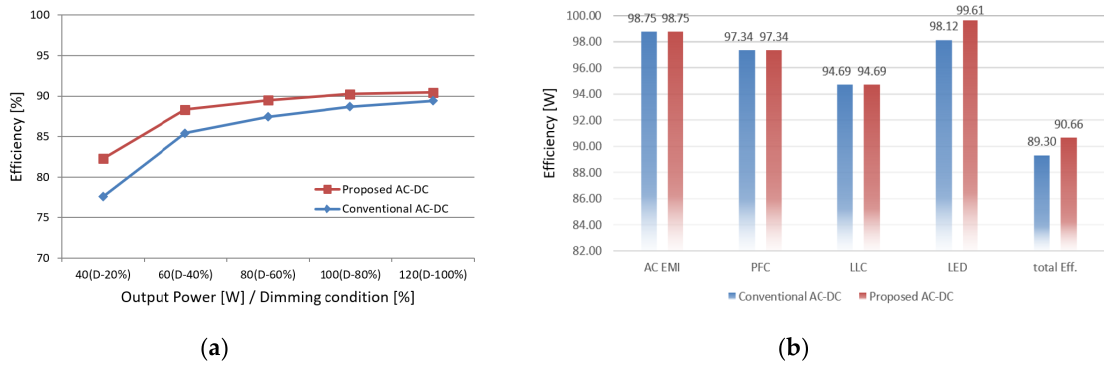
Figure 12. Measured total efficiency (AC to LED backlight driver): ( a ) comparison of efficiency by LED dimming conditions; ( b ) comparison of efficiency by each Stage (AC EMI + PFC + LLC + LED backlight).